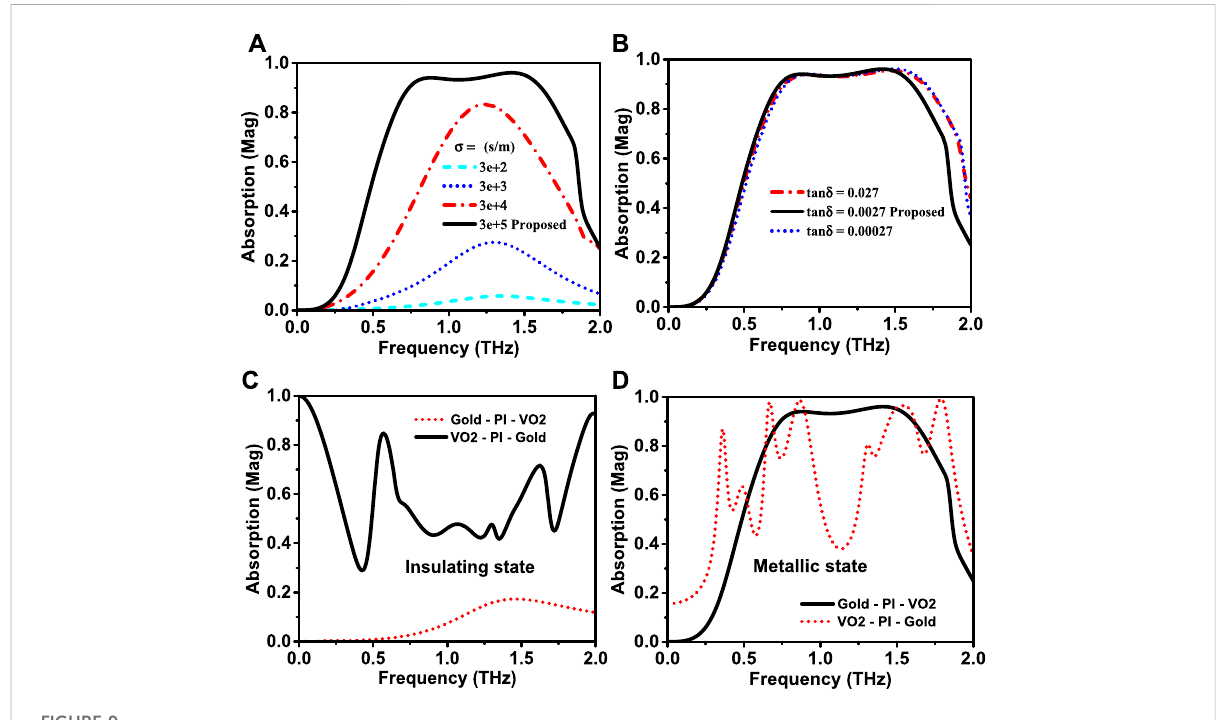
FIGURE 9 (A) Simulated results showing the absorption response at different conductivities of VO 2 , (B) at varied loss tangent of the proposed design, and (C) Absorption spectrum of the Gold-PI-VO 2 structure and VO 2 -PI-Gold structure when VO 2 is in the insulating state and (D) in the conducting (metallic) state.